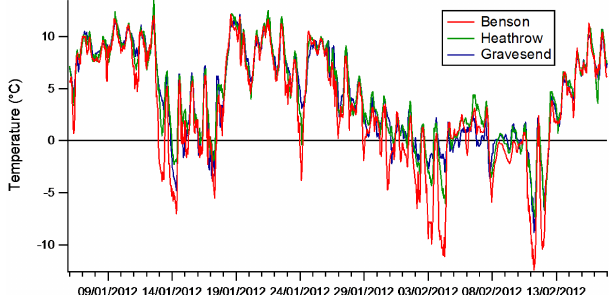
Figure 2. Time series of the temperature at three Met stations used for the entire winter